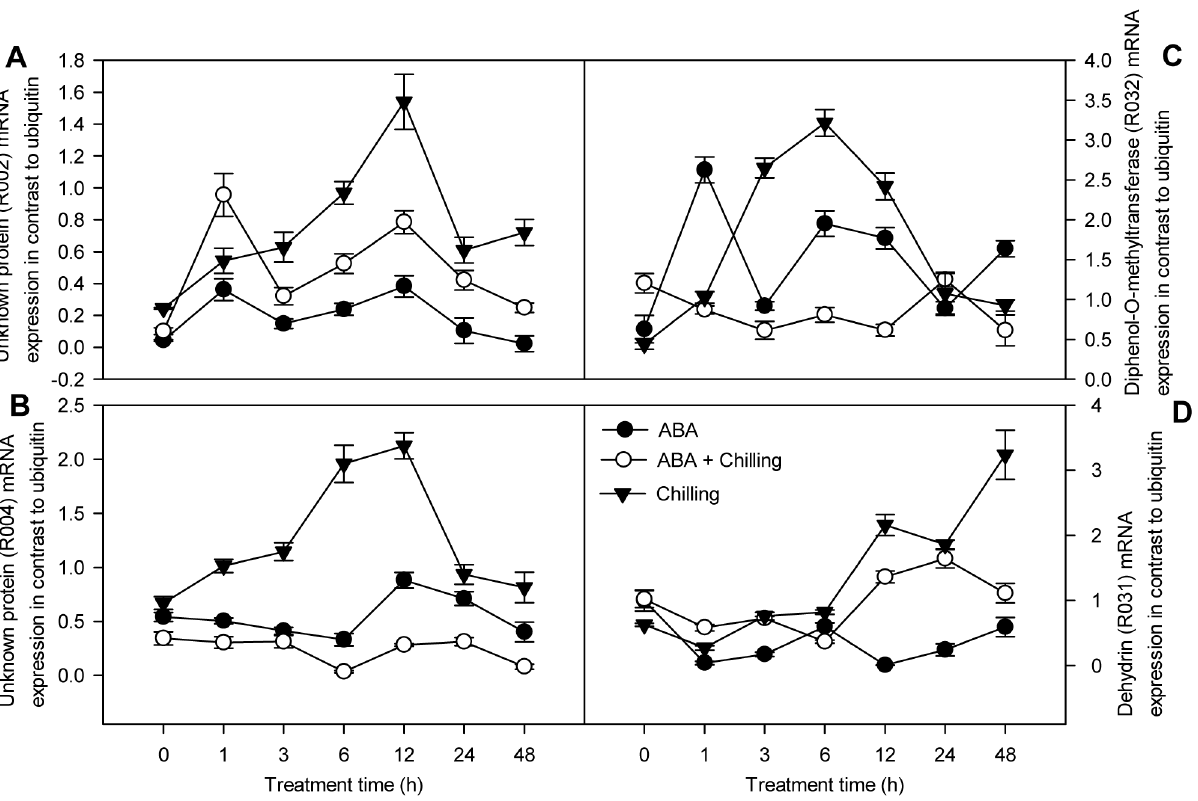
Figure 7. qPCR analysis of downregulated genes in the reverse SSH library. Total RNA was extracted from pepper leaves with ABA spray or water, subsequently 72 h after foliar application exposed to low temperature for 48 h to 6 u C. SE was calculated based on three biological replicates. Closed circle: ABA-pretreated samples under room temperature; open circle: ABA-sprayed samples prior to chilling stress; triangle down: water- sprayed samples prior to chilling stress. The level of ubiquitin was used as an internal reference gene.